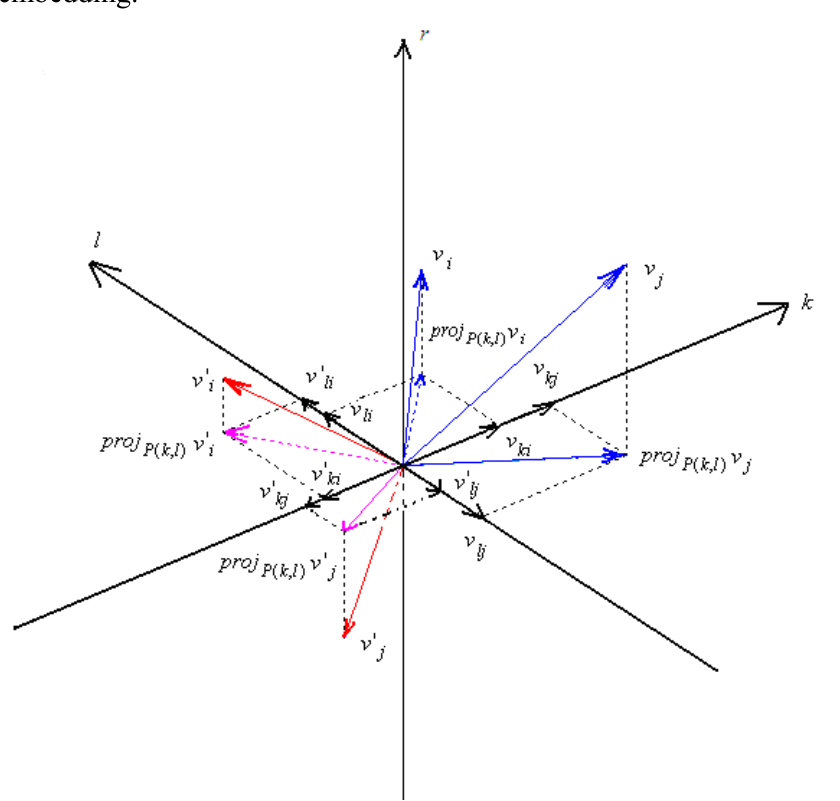
Figure 1. Three-dimensional visual representation of the vectors involved in the watermark